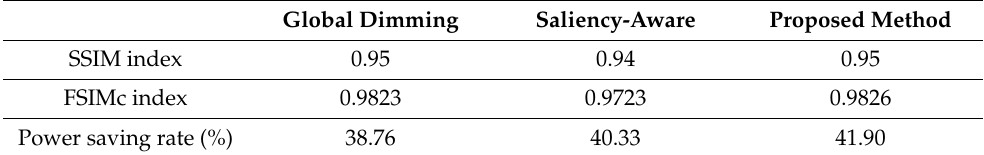
Table 3. Comparison of power savings and FSIMc.